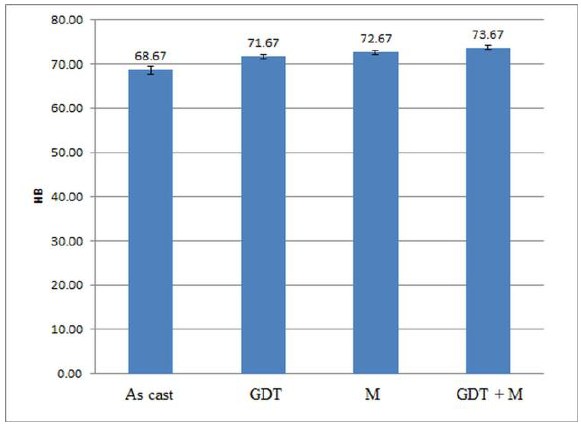
Figure 9. Results of hardness measurements performed on A356